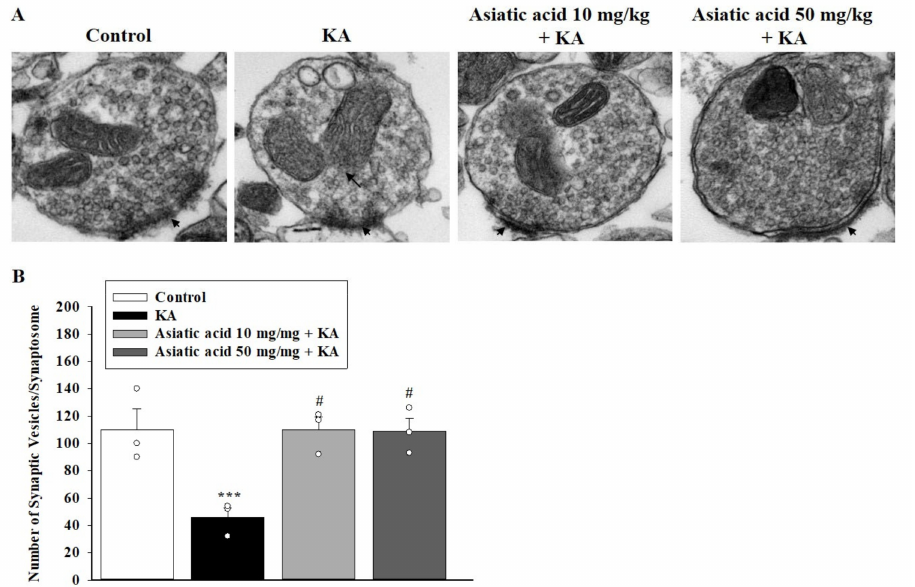
Figure 6. ( A ) Representative transmission electron micrographs of the hippocampal synaptosomal ultrastructure. Each synaptosome contains mitochondria, numerous synaptic vesicles, and a synaptic junction with postsynaptic density (arrowhead). Severe mitochondrial swelling accompanied by a disruption in membrane integrity (arrows). Scale bar, 200 nm. ( B ) The number of synaptic vesicles in the hippocampal synaptosomes was counted. *** p < 0.001(vs. control); # p < 0.001 (asiatic acid + KA vs. KA); n = 3 rats per